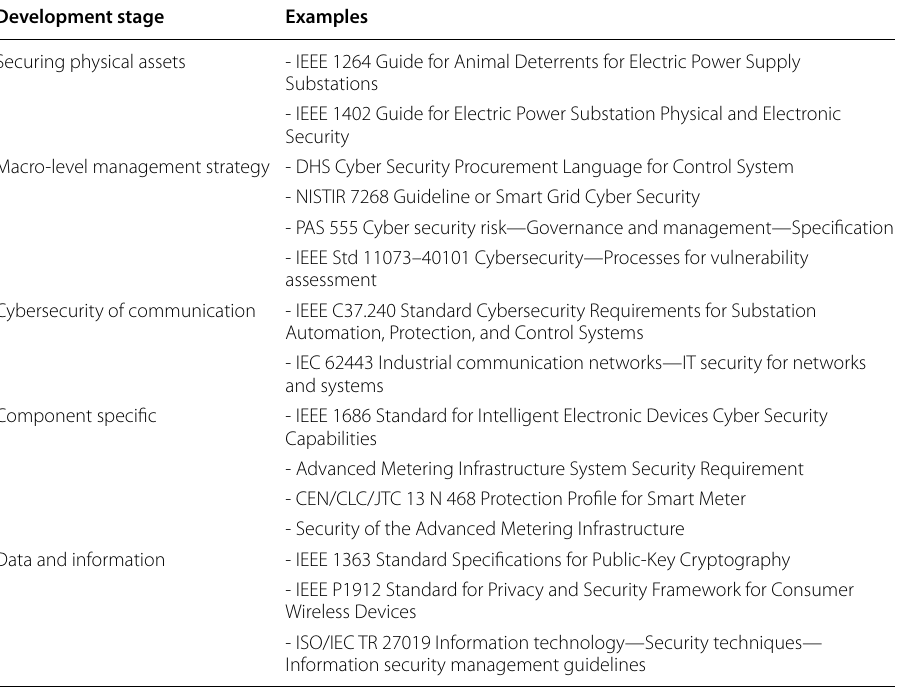
Table 2 Categories of cybersecurity development Development